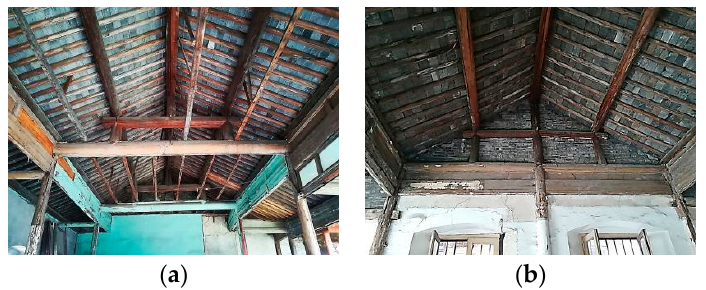
Figure 2. Structure types; ( a ) post and lintel construction frame; ( b ) column and tie construction frame.